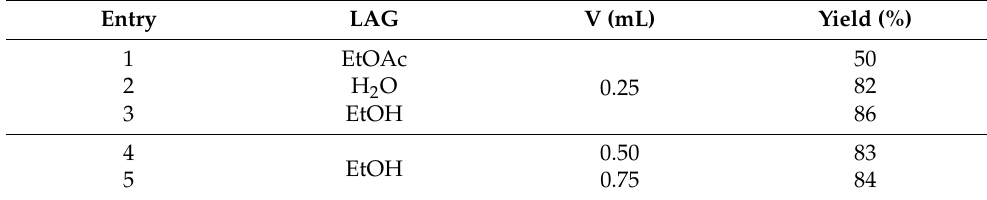
Table 2. Influence of nature and quantity of LAG for the mechanosynthesis of 1a in the SPEX